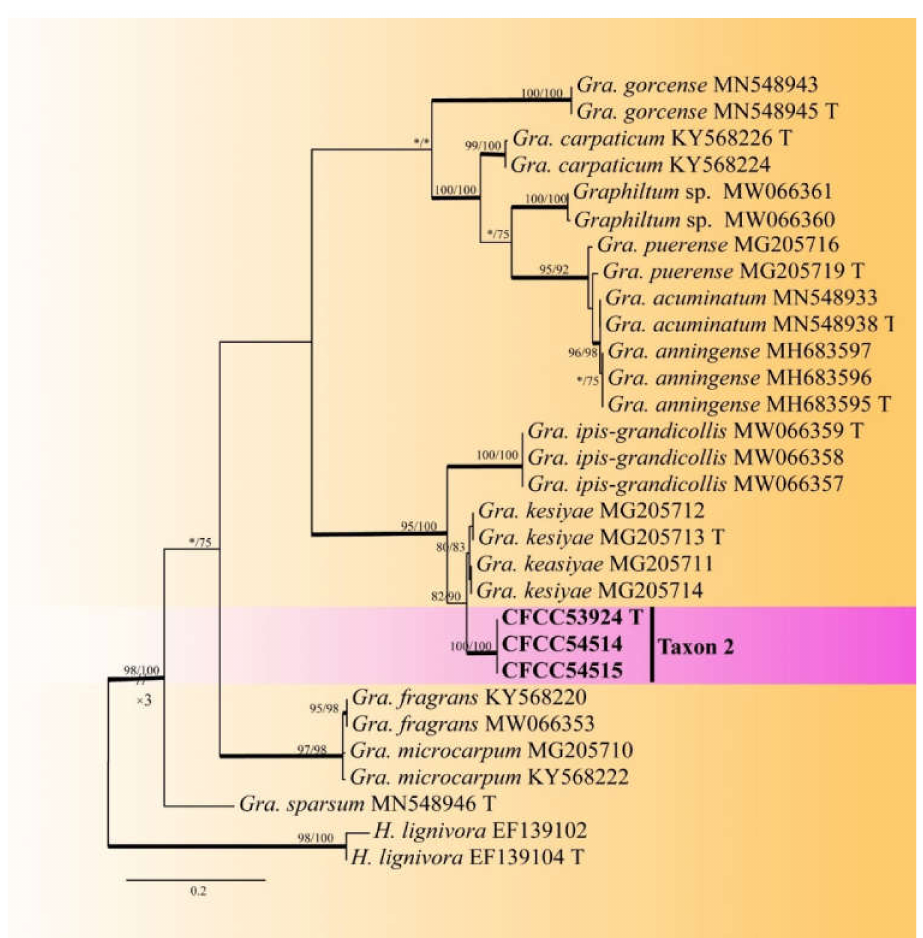
Figure 2. ML tree of Ophiostoma sensu lato and Graphilbum s. str . (Taxa 2, 6, and 7) generated from the ITS sequence data. Novel sequences obtained in this study are presented in bold typeface. Bold branches indicate posterior probability values ≥ 0.9. Bootstrap values ≥ 70% for ML and MP are indicated above branches. Bootstrap values < 70% are indicated by *. Strains representing ex-type sequences are marked with ‘T’.